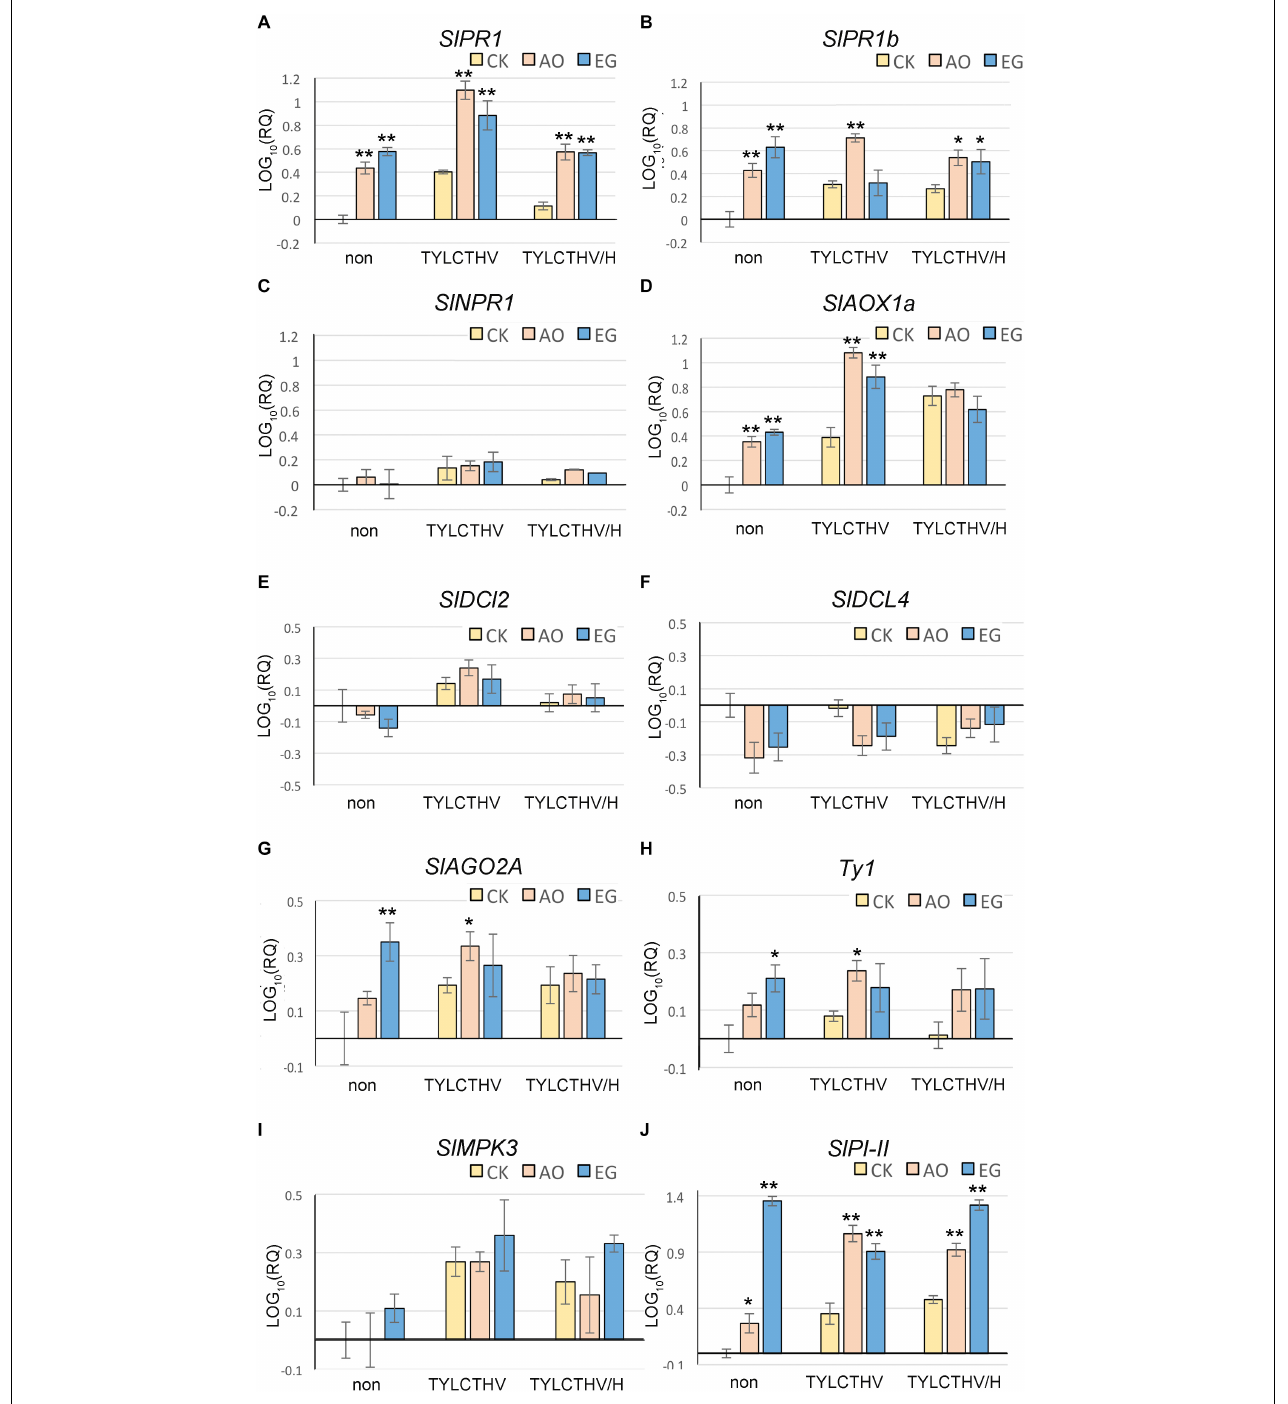
FIGURE 6 | Effects of anise oil and eugenol on the expression of defense-related genes in tomato plants under TYLCV infection with/without heat stress. Fourteen-day-old tomato seedlings treated with a control solution (CK), eugenol (EG), or anise oil (AO) for 24 h were inoculated TYLCTHV. Then, some plants were incubated at 45 ◦ C for 12 h. Total RNA was extracted from these plants. The expression levels of SA-related defense genes, SlPR1 (A) , SlPR1b (B) , SlNPR1 (C) , and SlAOX1a (D) , RNA silencing genes, SlDCL2 (E) , SlDCL4 (F) , SlAGO2A (G) , and Ty-1 (H) , and JA-related defense genes, SlPI-II (I) and SlMAPK3 (J) , were analyzed by RT-qPCR. The β -actin expression level was used as the internal control. Relative gene expression levels were normalized against the expression level in control. Data were analyzed with the 2 − (cid:49)(cid:49) Ct method. Bars represent the mean ( ± standard error of the mean) of three independent biological replicates each with three technical replicates. Significant differences between control and anise oil- or eugenol-treated plants were assessed with Student’s t -test ( ∗ P < 0.05; ∗∗ P < 0.01).